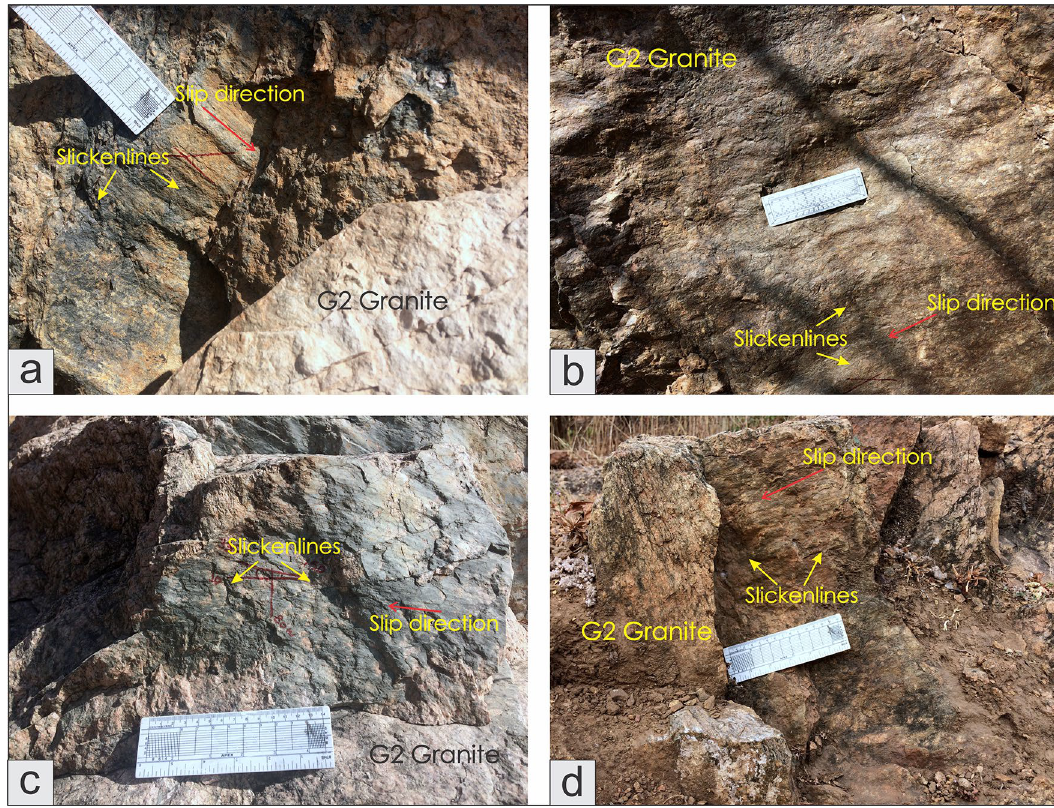
Figure 11. Observed fault surfaces with slicken fibers in the field. ( a ) Moderately dipping fault surface with normal slip, ( b ) A gently dipping oblique-slip fault, ( c ) Steeply dipping strike-slip fault with a sinistral sense of shearing, ( d ) A moderately dipping oblique-slip